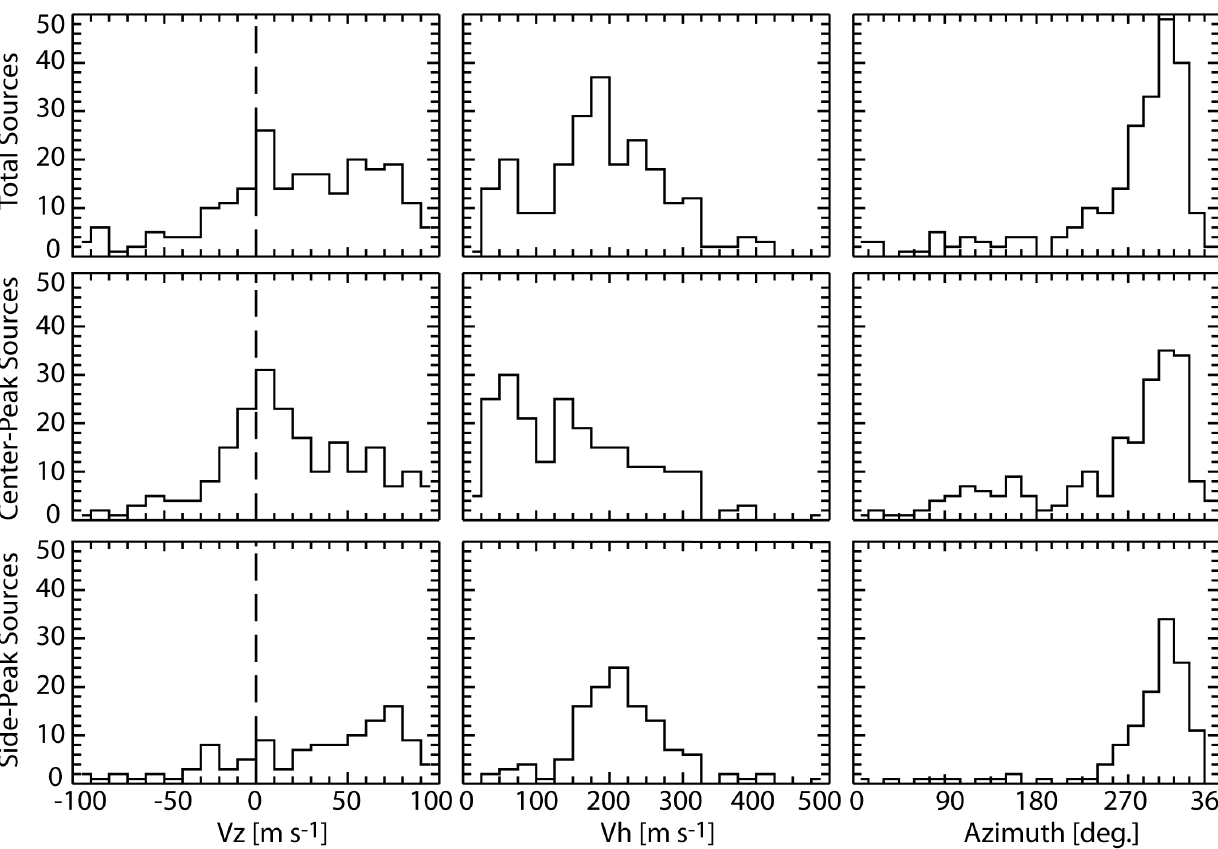
Fig. 12. Occurrence histograms of vertical velocity (V z ) , horizontal velocity (V h ) , and azimuth angle used for computations: (top row) all Doppler spectral lines between ± 3.125Hz; (middle row) only Doppler spectral center-peak lines between ± 0.781Hz; and (bottom row) only Doppler spectra side-peak lines between ± 0.781 and ± 3.125Hz. For all cases, we assumed that the E-region undergoes uniform bulk motion. The velocity components are expressed in a compass oriented coordinate